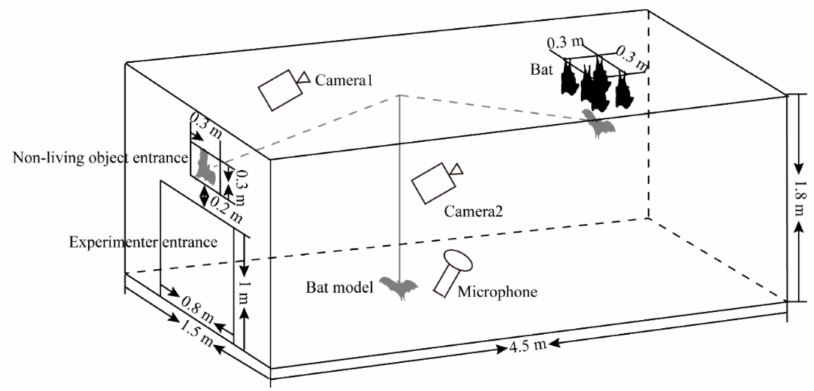
Figure 2. A schematic diagram of the territory defense experiment using intrusive non-living objects and roosting Hipposideros armiger . The intrusive object is shown in grey to distinguish it from roosting